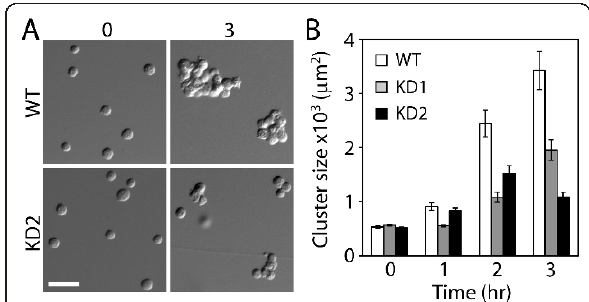
Figure 2 Vinculin knock-down decreases cell-cell adhesion . (A) Cell clustering in the hanging drop adhesion assay of wild-type (WT) and knockdown (KD2) cells. Time in hours. Scale bar 50 μ m. (B) Quantification of clustering size of wild-type and knockdown (KD1 and KD2) cells. Error bars are standard error of the